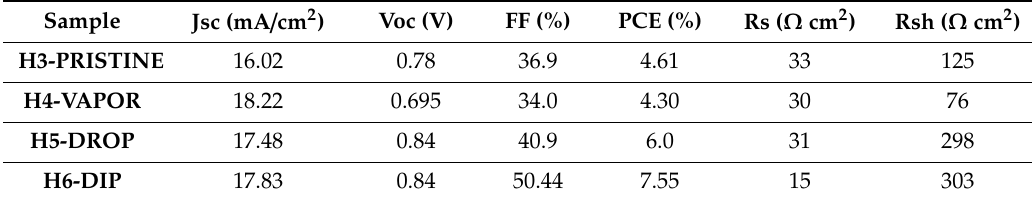
Figure 11. Current density–voltage curves under 100 mW/cm 2 AM 1.5G illumination for hybrid photovoltaic structures using pristine PEDOT:PSS film post-treated IPA PEDOT:PSS films using VAPOR, DROP, and DIP techniques. Table 3. Performance parameters of hybrid photovoltaic structures fabricated with pristine and post-treated PEDOT:PSS films.